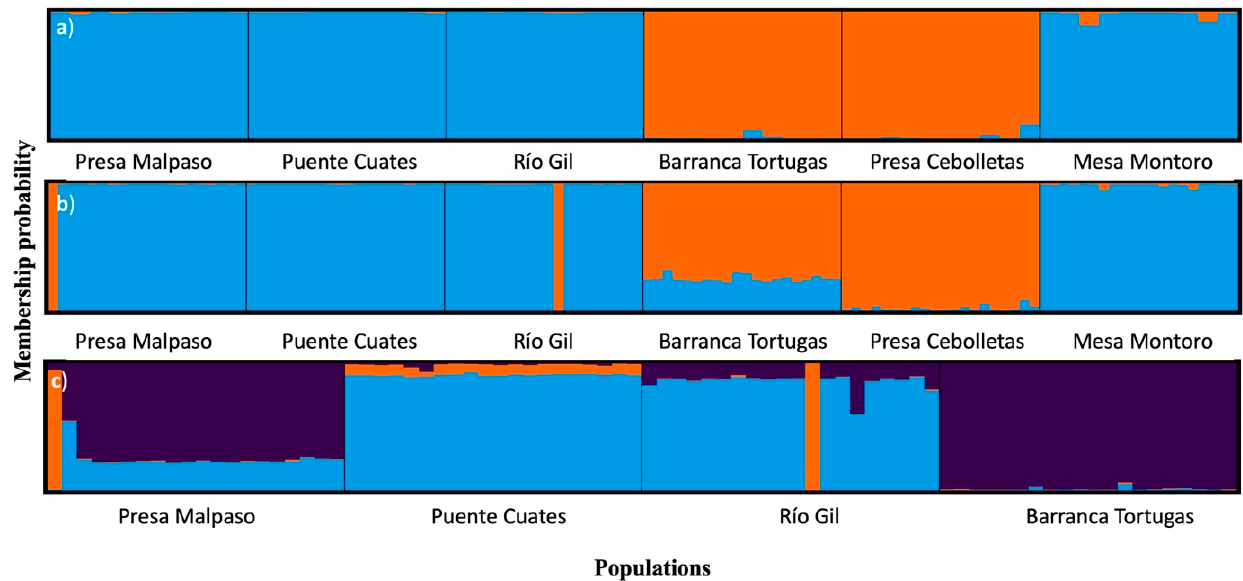
Figure 6. Genetic relationships among the populations of Pachyphytum caesium estimated using the STRUCTURE program based on ISSR data: ( a ) without simulation (120 individuals, see Figure 1); ( b ) with simulation of the extraction of individuals (60 individuals); and ( c ) the local extinction of two populations. The model with K = 2 and K = 3 showed the highest Δ K value.